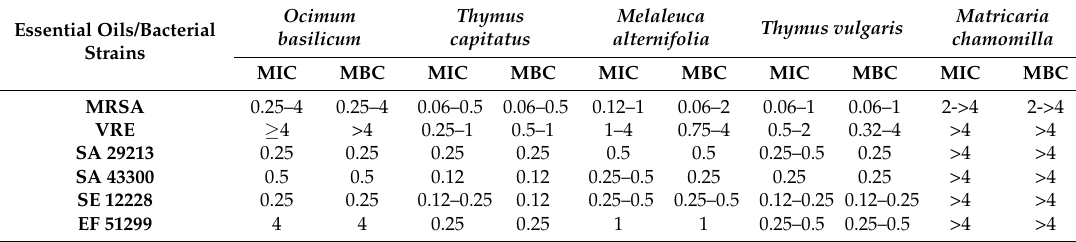
Figure 2. Time-kill kinetics for origanum oil, basil oil, tea tree oil, and thyme oil on a vancomycin resistant E. faecium (VRE no. 2) clinical isolate (isolated from wound swab).